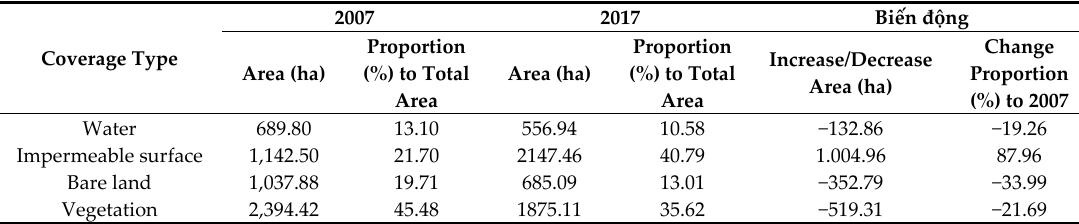
Table 1. Statistics of real coverage in inner-city areas and urbanization from 2007 to